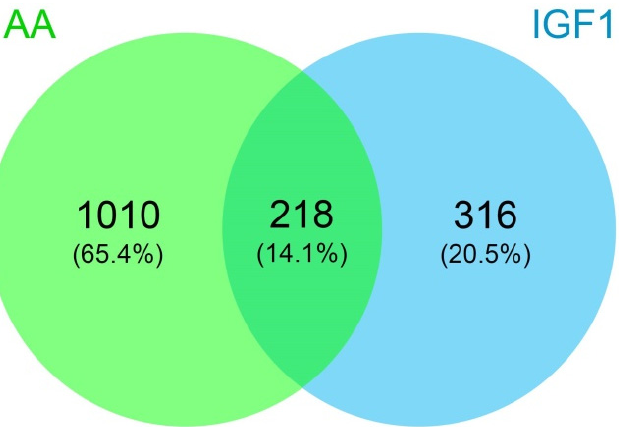
Figure 3. Venn diagram of genes differentially expressed in AA and IGF1 pacu-cultured myotubes. The Venn diagram showing different sets of differentially expressed genes considering the AA and IGF1 treatments, with 218 deregulated genes by both experimental groups.